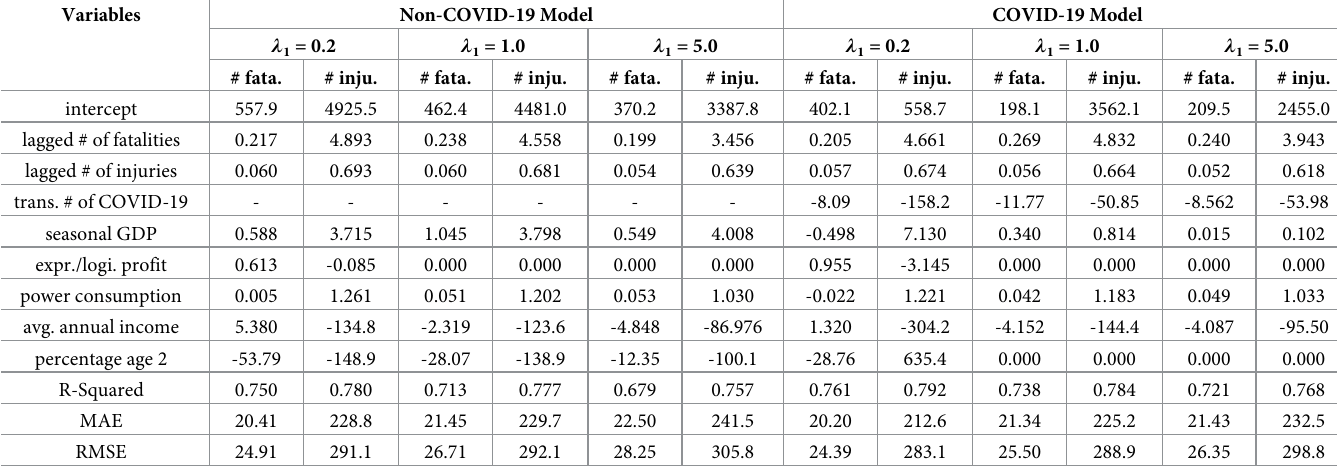
Table 2. Results of different country-level